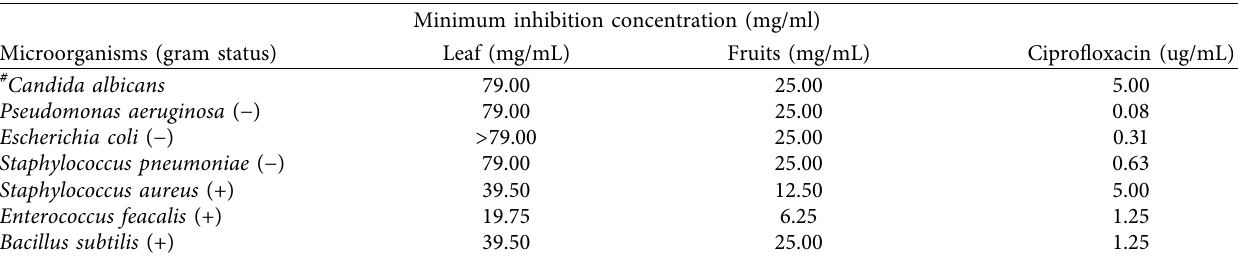
Table 5: Antimicrobial activity of the leaf and fruit essential oils of Vitex doniana .